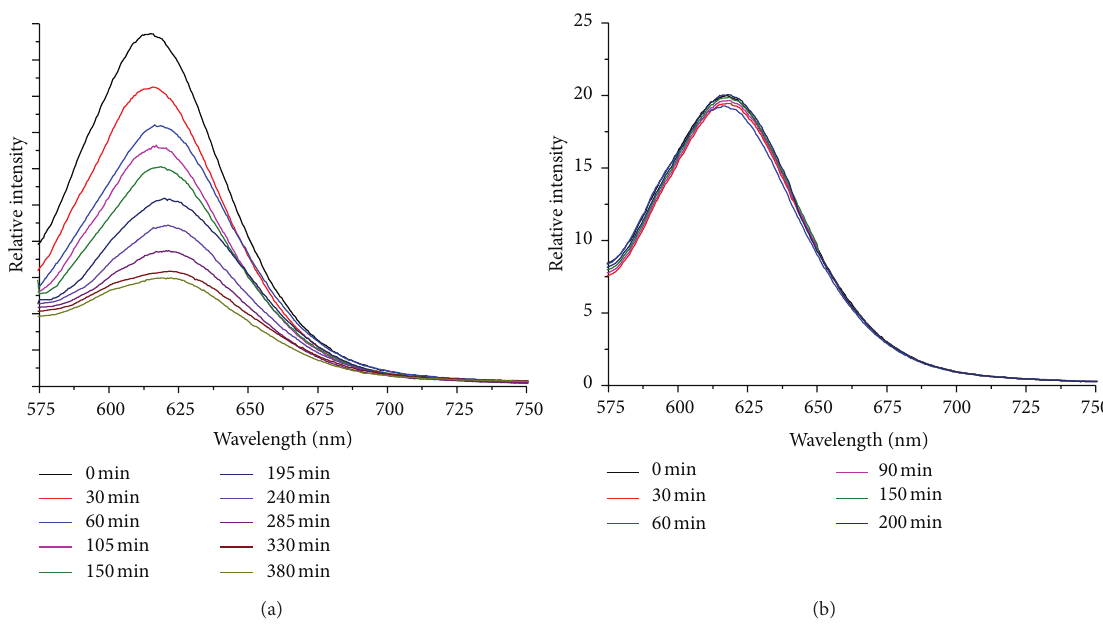
Figure 8: Fluorescence emission spectra ( 𝜆 = 550 nm) of the p1 micellar solution (a) loaded with both UCNPs and Nile Red; (b) with only ex encapsulated Nile Red under 980 nm NIR light (8